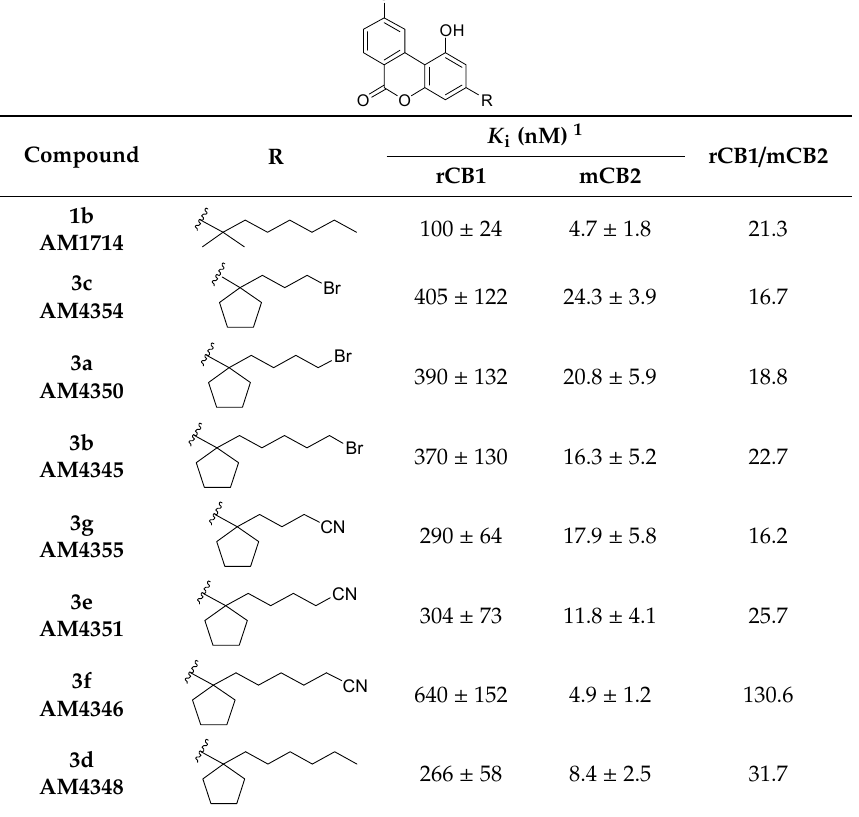
Table 1. Affinities of side chain-modified cannabilactone analogs for rCB1 and mCB2 cannabinoid receptors (± 95% confidence limits).